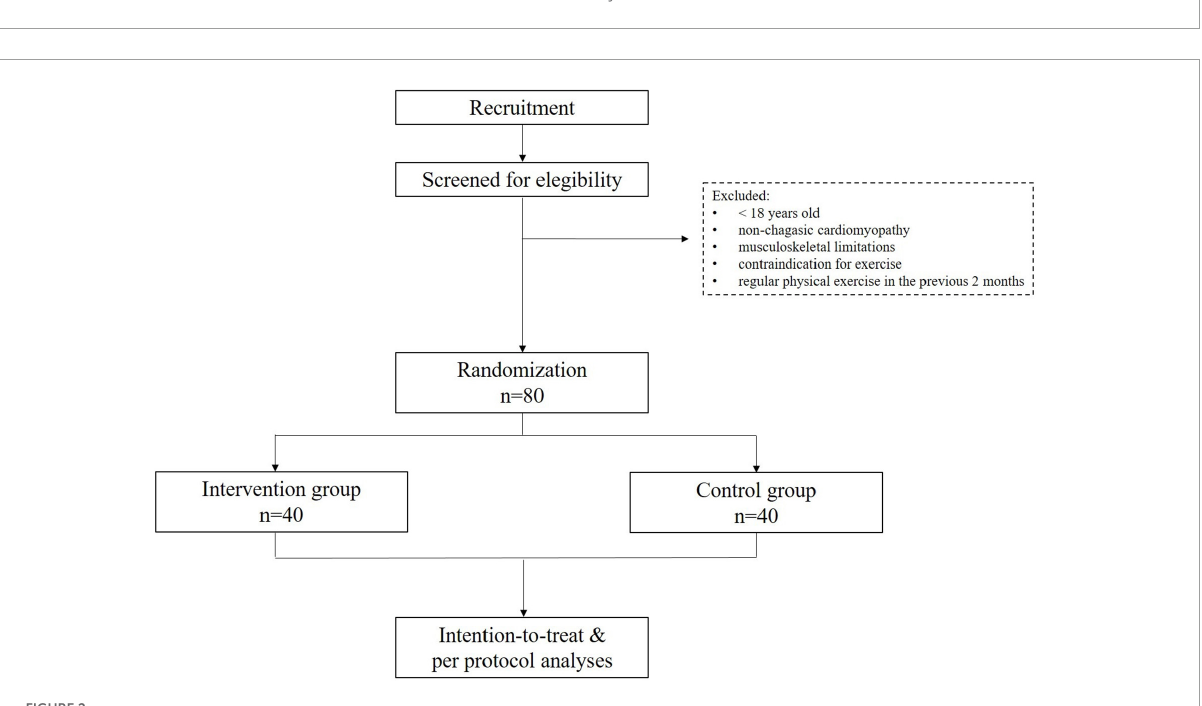
FIGURE2 Planned flow diagram of the